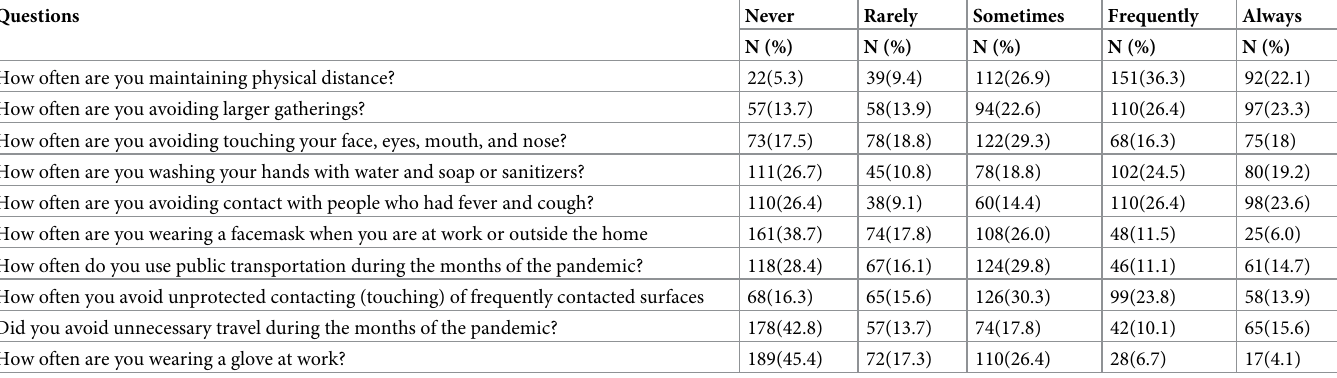
About 27% of the respondents never keep physical distance, while only 5% keep physical dis- tance always. About 18.8% and 19.2% of the respondents wash their hands with water and soap or with sanitizer frequently and always, respectively. Only 6% of the respondents using facemasks at work or outside their home always, and about 6.7% and 4% were using gloves fre- quently and always, respectively (Table 3). The overall proportion of study participants with good COVID-19 preventive behavior were only 21.2%. The common barriers reported were the difficulty of maintaining social distance at work due to the nature of their work, shortage of facemasks and gloves, and high efforts needed to implement prevention measures (Fig 3). Risk perception and self-efficacy to practice preventive measures Two hundred twenty-two (53.4%) of the participants had a high-risk perception towards COVID-19, while the remaining 46.6% had a low-risk perception. Besides, 53.1% of study par- ticipants had high self-efficacy to practice COVID-19 preventive methods. Table 3. Preventive behavior of COVID-19 virus among waiters working in food and drinking establishments, Southwest Ethiopia, 2020.